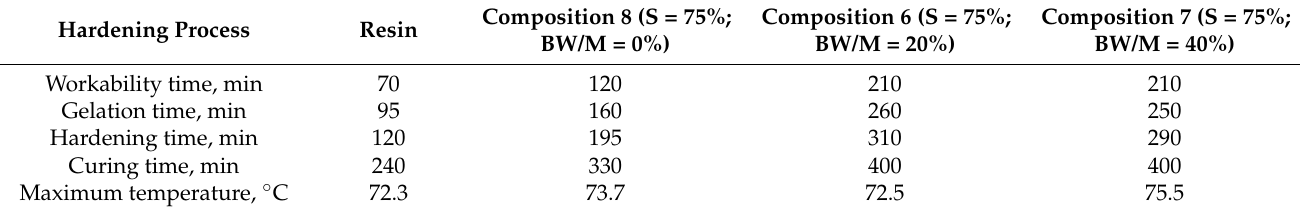
Figure 5. Binding course of the analyzed composites. Table 3. Binding characteristics of the composite depending on the proportion of biochar.